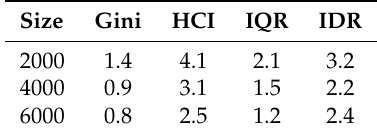
Table 9. Relative RMSE (%) of each parameter applying PSA with the proportional reference sample.